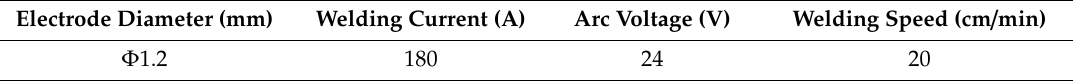
Table 3. Welding parameters.